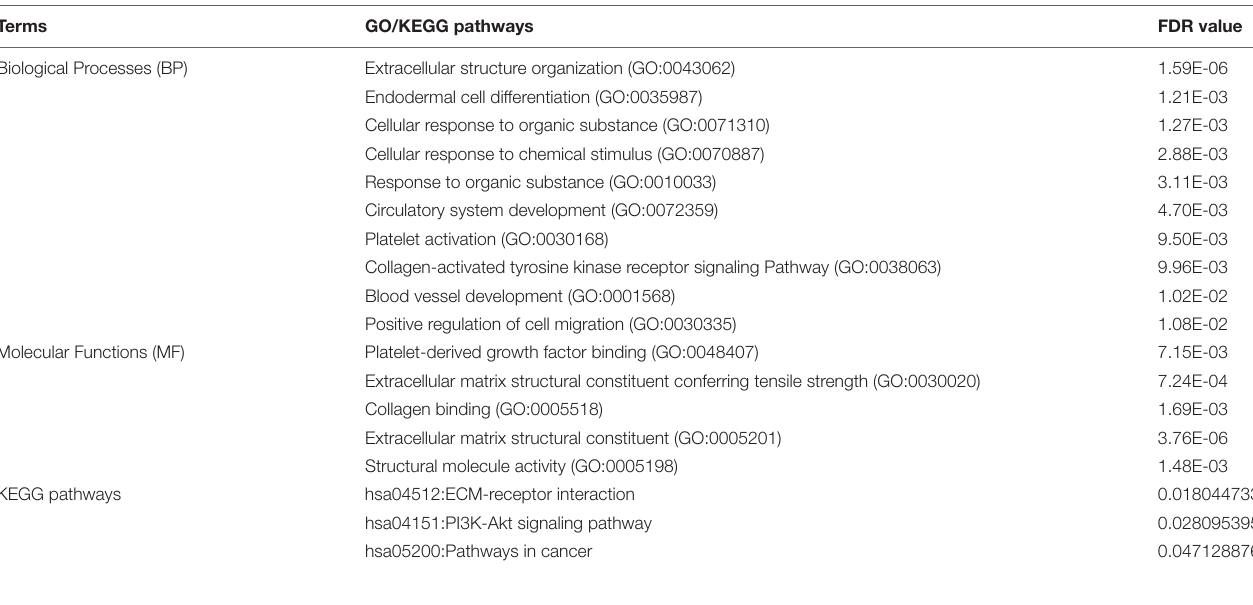
TABLE 5 | List of some of the enriched GO and KEGG pathways of hub